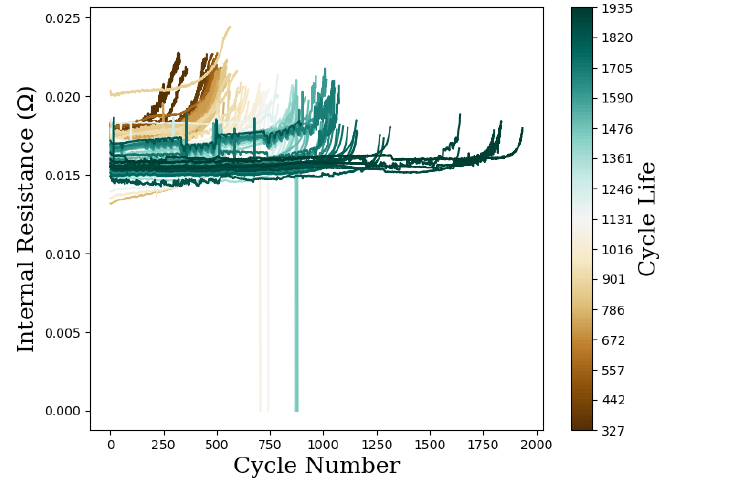
Figure 5. Internal resistance of all analyzed cells. The different colors indicate the corresponding cell cycle life. The higher the internal resistance, the shorter the lifetime. The cells with the shortest lifetimes belonged to batch “2017-06-30”, which was the batch with longer resting times. The batches differed regarding the resting